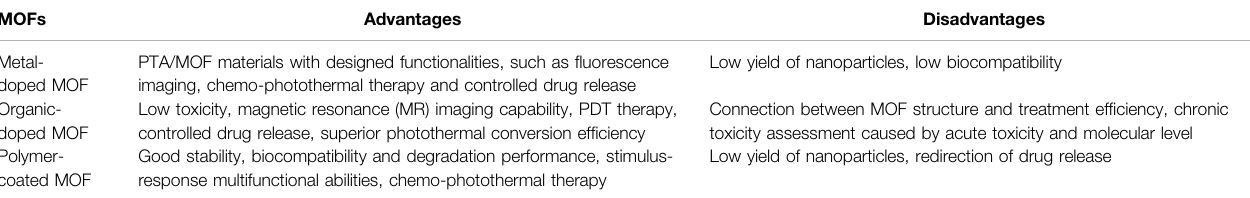
TABLE 2 | The advantages and disadvantages of the three categories MOFs Advantages Metal- doped MOF Organic- doped